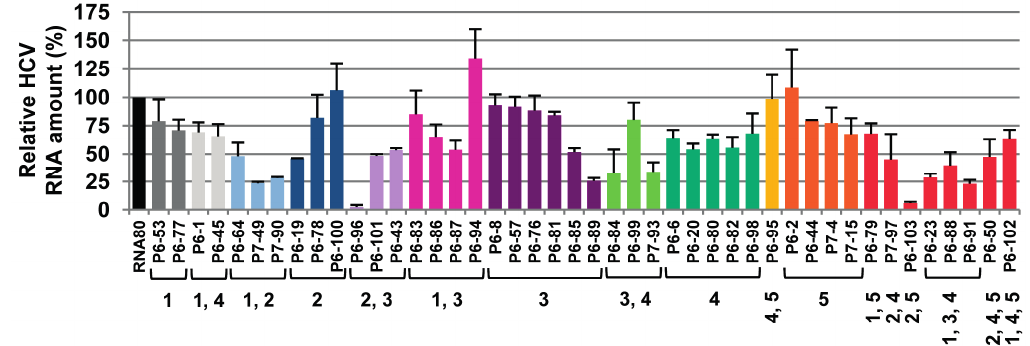
Figure 2. Inhibition of subgenomic HCV replicon replication in a hepatoma cell line. Huh-7 cells supporting the autonomous replication of subgenomic HCV replicons were